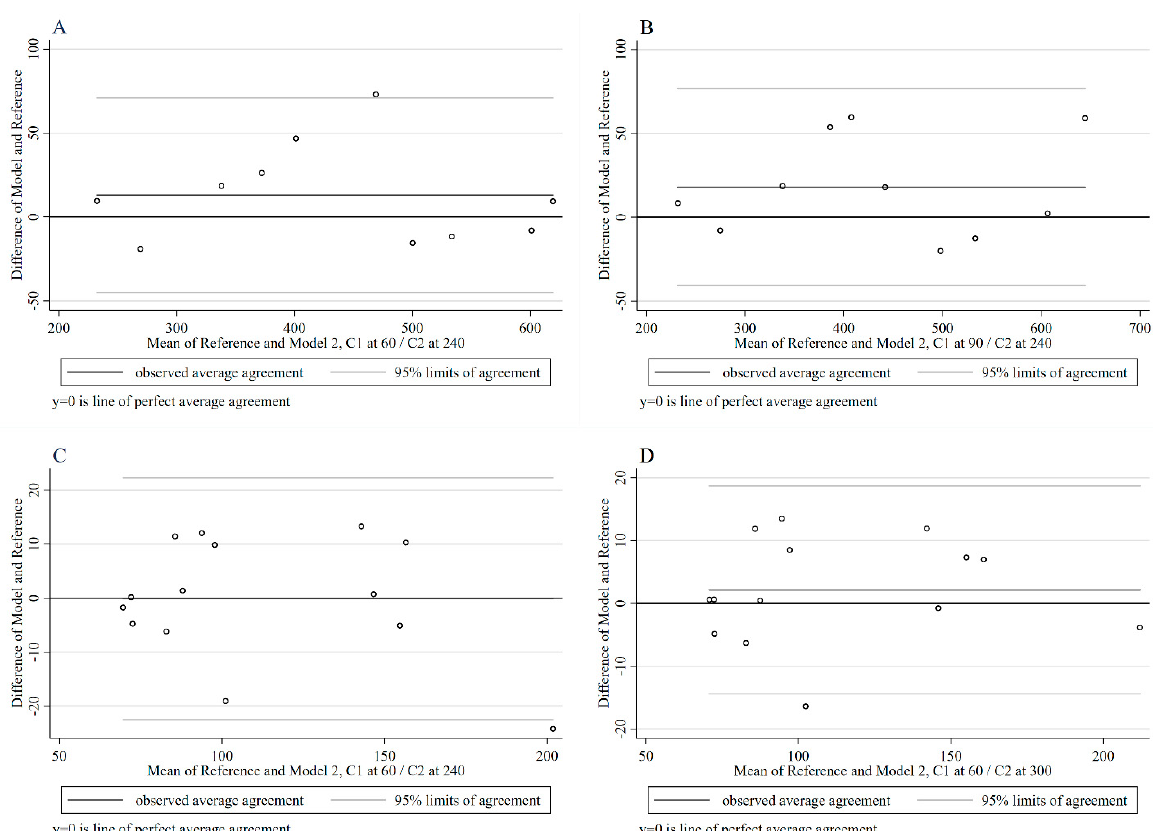
Figure 1. Summary of intersected C1 and C2 windows as inputs of the first-order pharmacokinetic equation using Model 2.